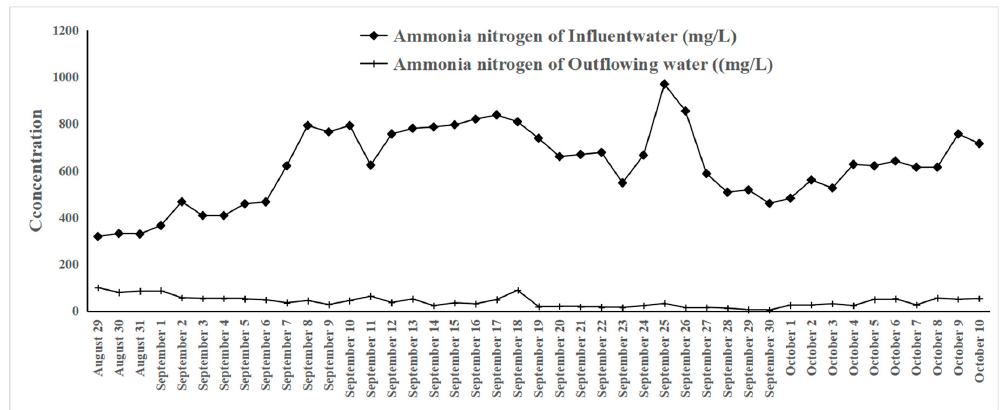
Figure 6. Ammonia nitrogen concentration change in the SBR reactor.